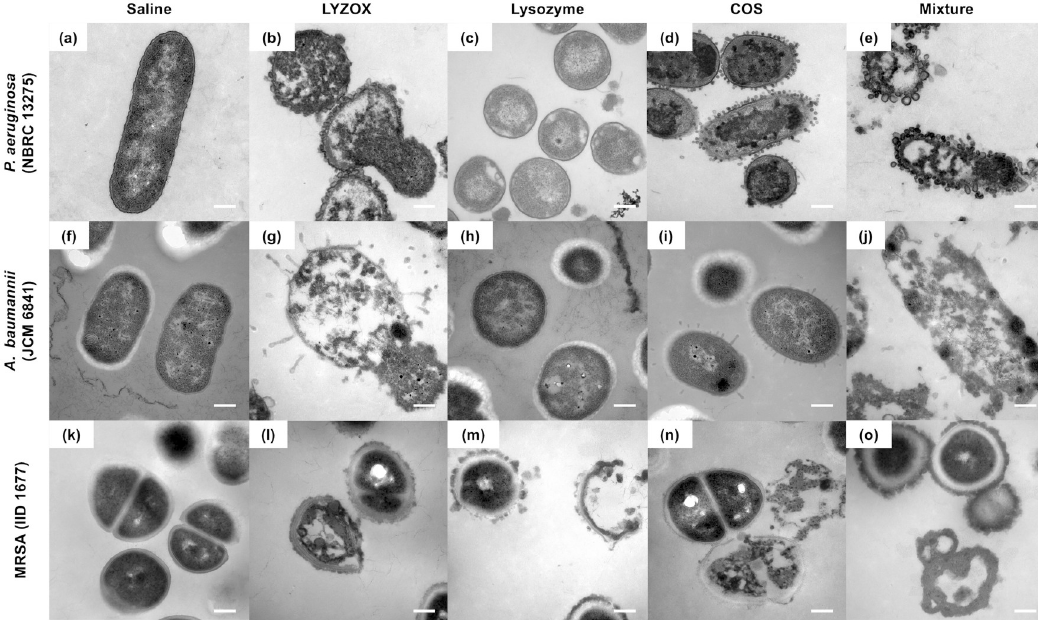
Fig 8. Transmission electron microscopic findings in Pseudomonas aeruginosa , Acinetobacter baumannii and methicillin- resistant Staphylococcus aureus . Transmission electron micrographs of Pseudomonas aeruginosa (NBRC 13275) (a, b, c, d, e), Acinetobacter baumannii (JCM 6841) (f, g, h, i, j) and MRSA (IID 1677) (k, l, m, n, o) incubated with each treatment for 2 h. (a), (f) and (k) were not treated (control). (b), (g) and (l) were treated with lysozyme-chitosan oligosaccharide conjugate (LYZOX, 1,000 μ g/ mL). (c), (h) and (m) were treated with lysozyme (500 μ g/mL). (d), (i) and (n) were treated with chitosan oligosaccharide (COS, 500 μ g/mL). (e), (j) and (o) were treated with the mixture (lysozyme [500 μ g/mL] and COS [500 μ g/mL]). Bacteria were photographed at a magnification of of × 50,000. Scale bar = 0.2 μ m.